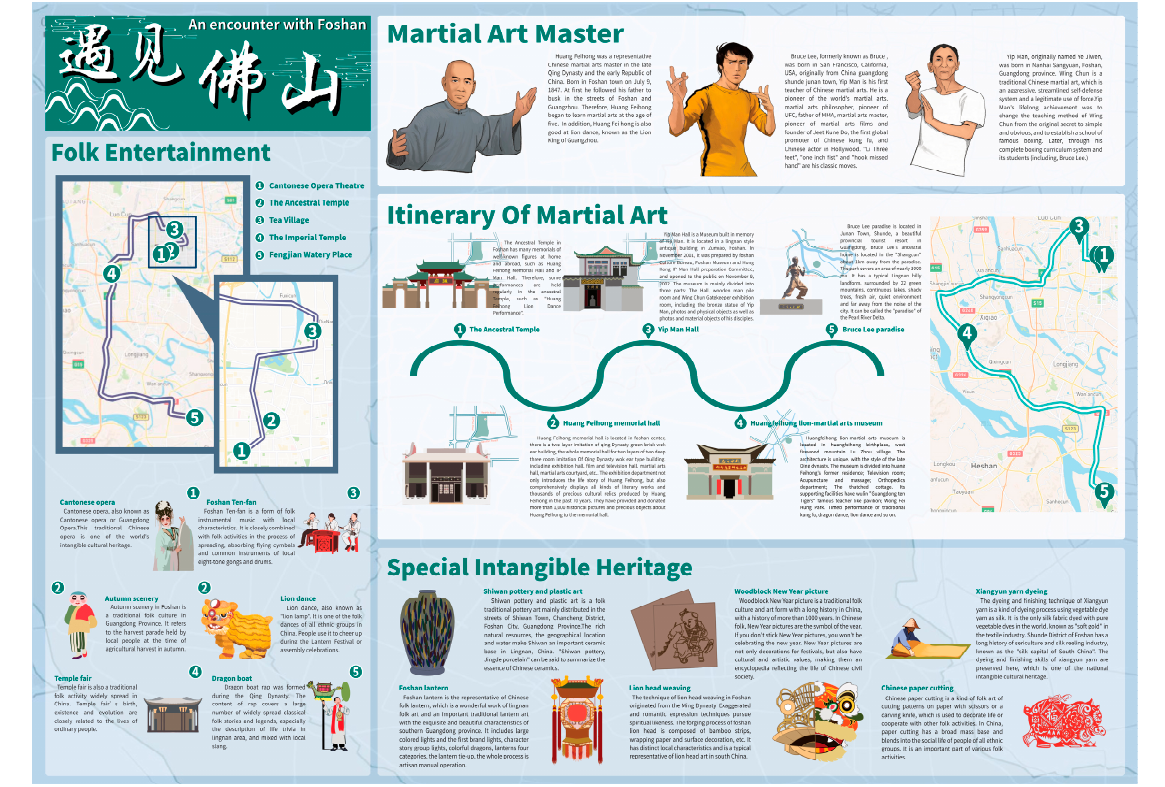
Figure 10. Tourist map of Foshan (Back of the